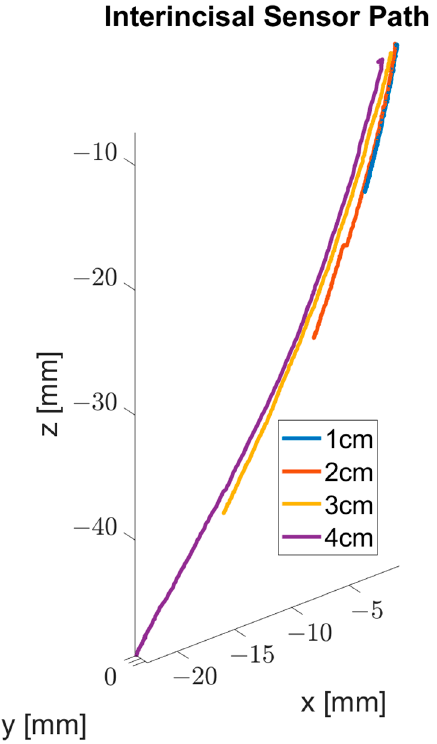
Figure 8. 3D visualization of the outline of the interincisal sensor.